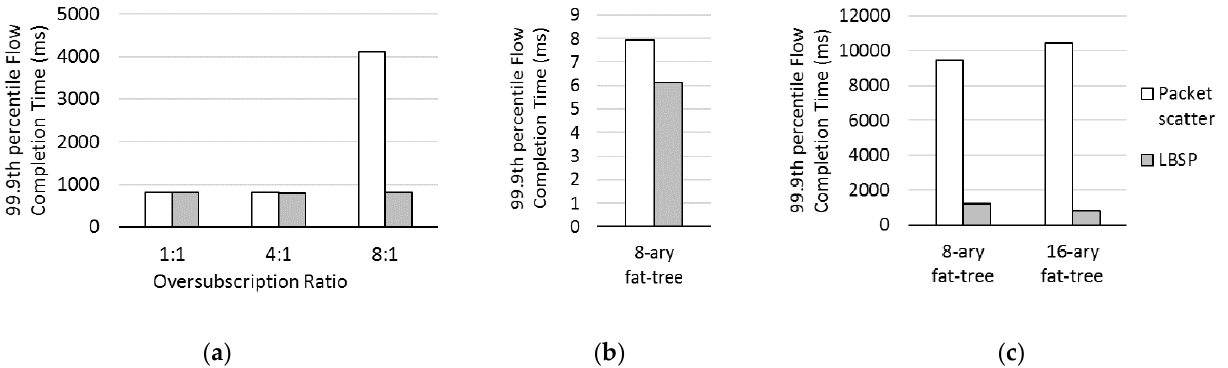
Figure 7. ( a ) Flow completion time in long-lived flow tests for 16-ary fat-tree with one link failure; ( b ) result of a short-lived flow test with degraded links; and ( c ) result of long-lived flow tests with degraded links.